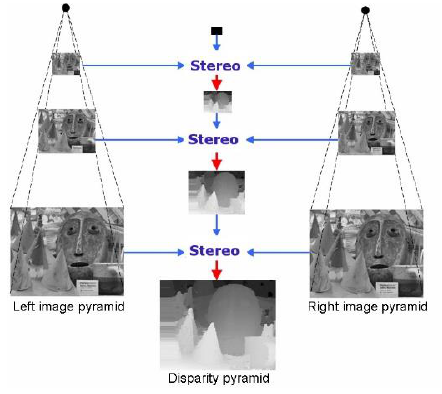
Figure 6. stereo correspondence